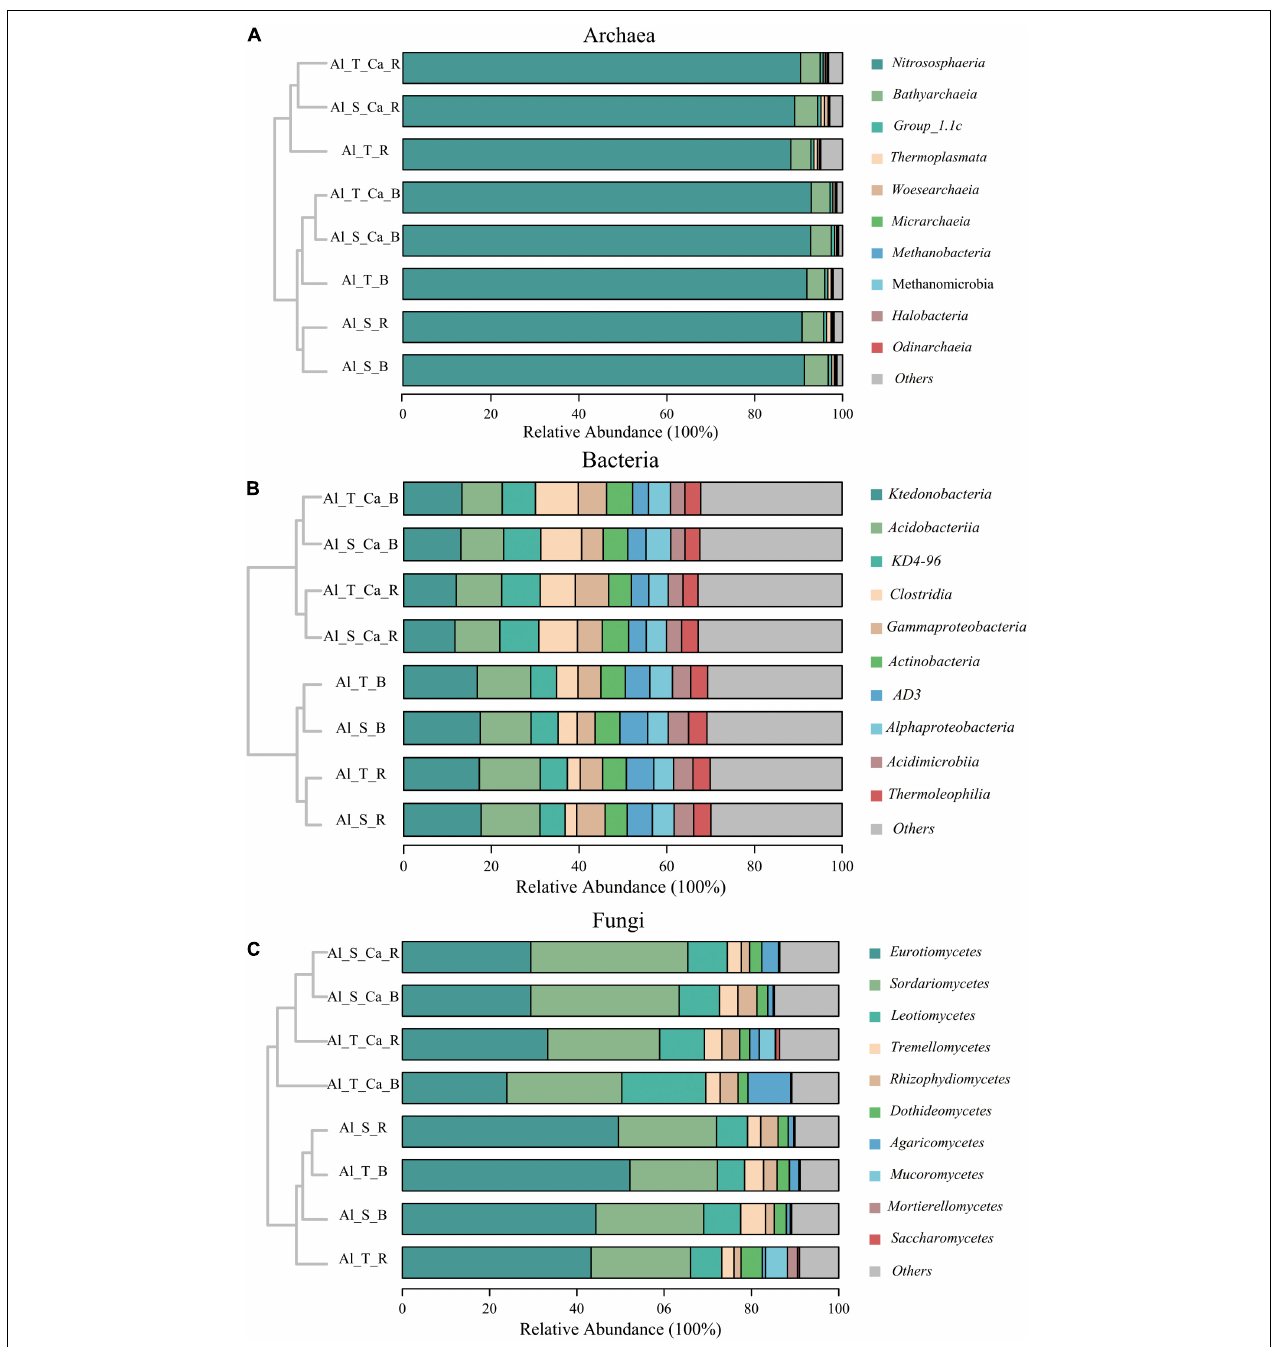
FIGURE 3 | Hierarchical cluster analysis and relative abundance of the dominant archaea (A) , bacteria (B) , and fungi (C) in the bulk and rhizosphere soils under liming and non-liming conditions. Al_S_B, Al-sensitive rice bulk soil; Al_S_R, Al-sensitive rice rhizosphere soil; Al_T_B, Al-tolerant rice bulk soil; Al_T_R, Al-tolerant rice rhizosphere soil; Al_S_Ca_B, Al-sensitive rice and CaCO 3 bulk soil; Al_S_Ca_R, Al-sensitive rice and CaCO 3 rhizosphere soil; Al_T_Ca_B, Al-tolerant rice and CaCO 3 bulk soil; Al_T_Ca_R, Al-tolerant rice and CaCO 3 rhizosphere soil.